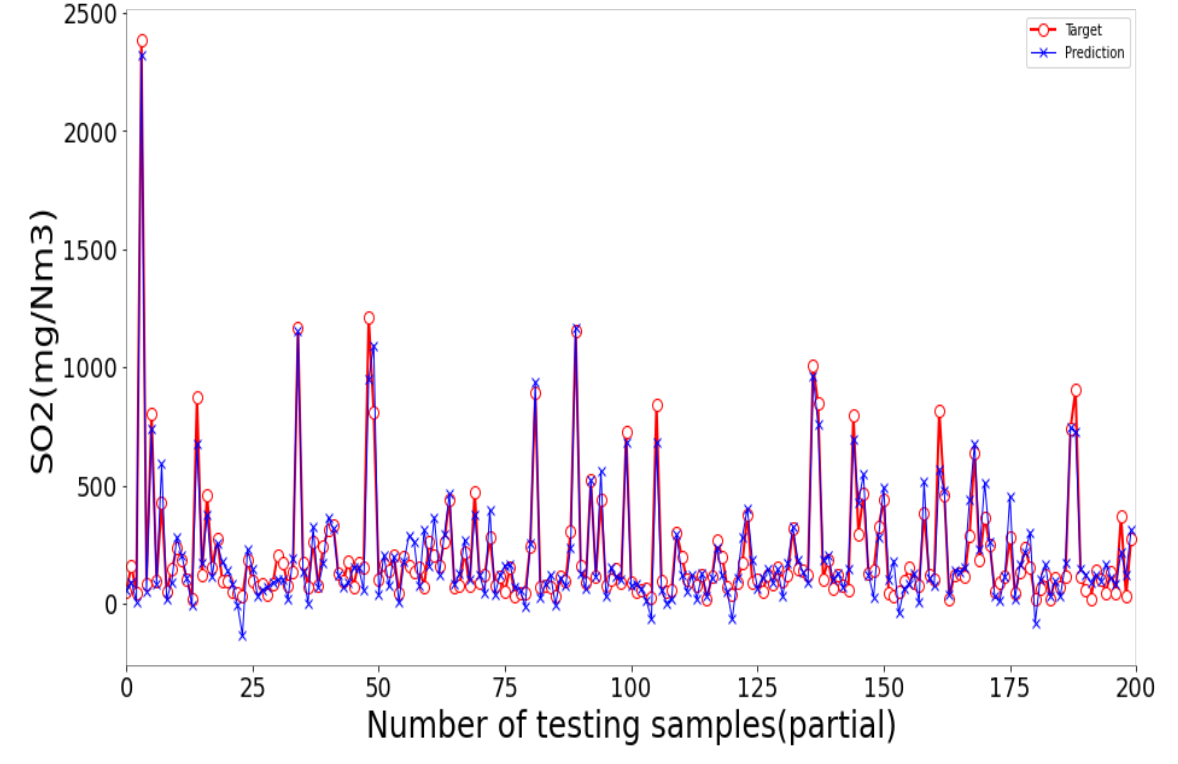
Figure 6. The fitting diagram of SO 2 emission concentration model.